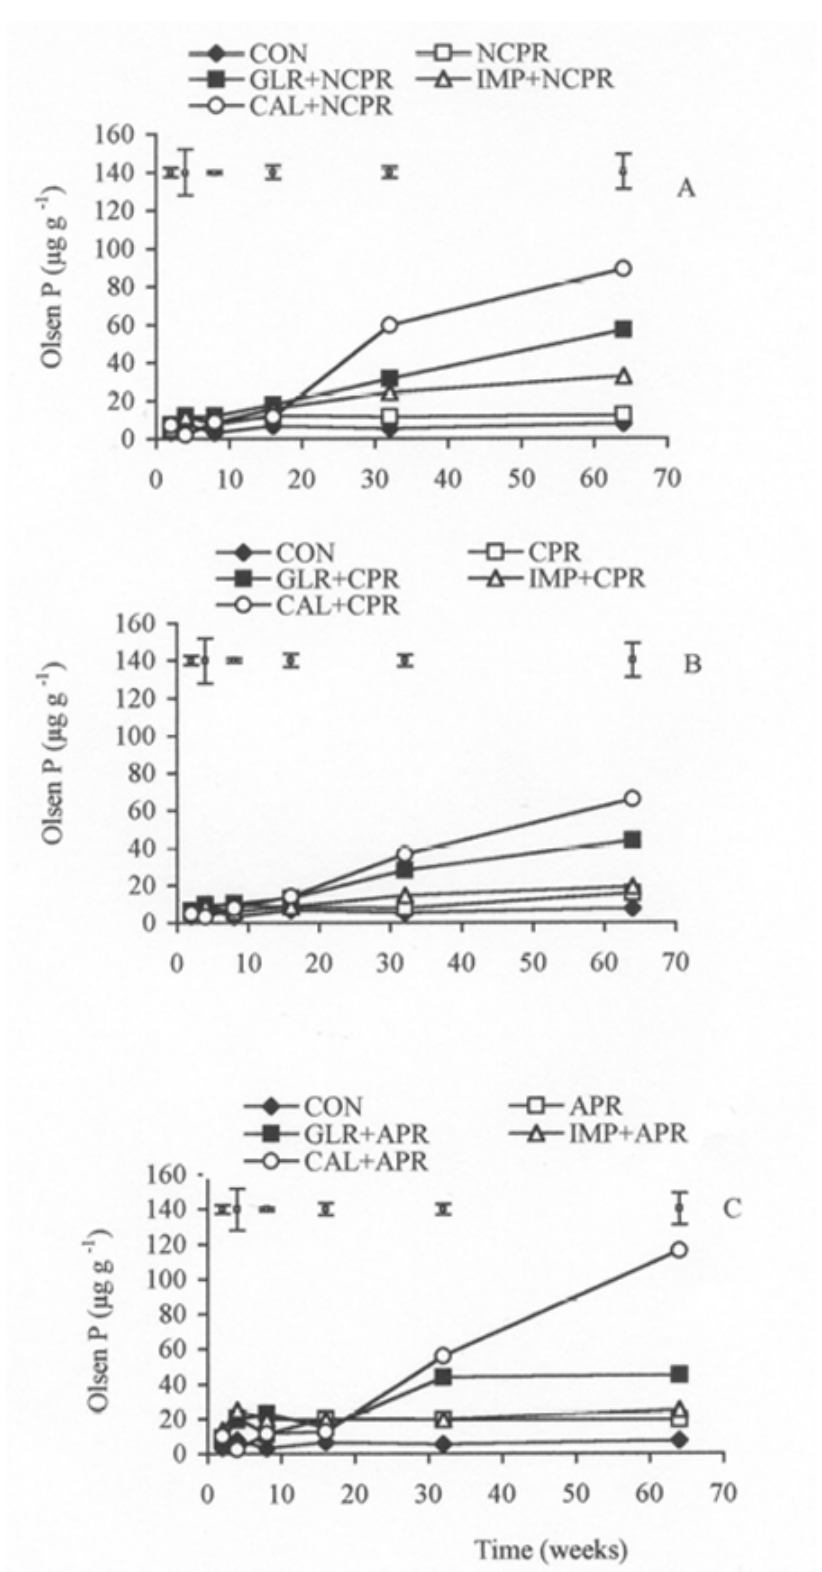
FIGURE 5. Changes in Olsen P in a tropical soil treated with GMs and PRs. (A) NCPR = North Carolina PR; (B) CPR = China PR; (C) APR = Algerian PR. Bars = LSD 0.05 .